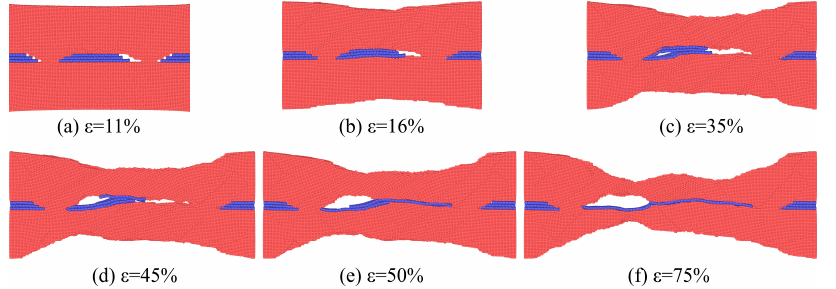
Figure 13. Atomic configuration diagram of Gr/Cu-3 under different strains during stretching. ( a ) ε = 11%, ( b ) ε = 16%, ( c ) ε = 35%, ( d ) ε = 45%, ( e ) ε = 50% and ( f ) ε = 75%.